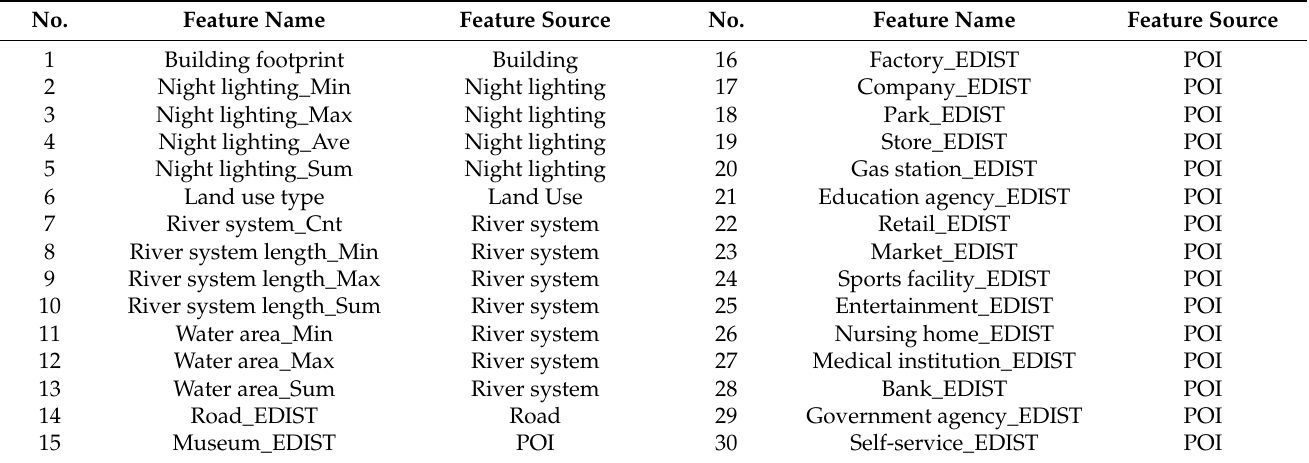
Table 3. List of filtered